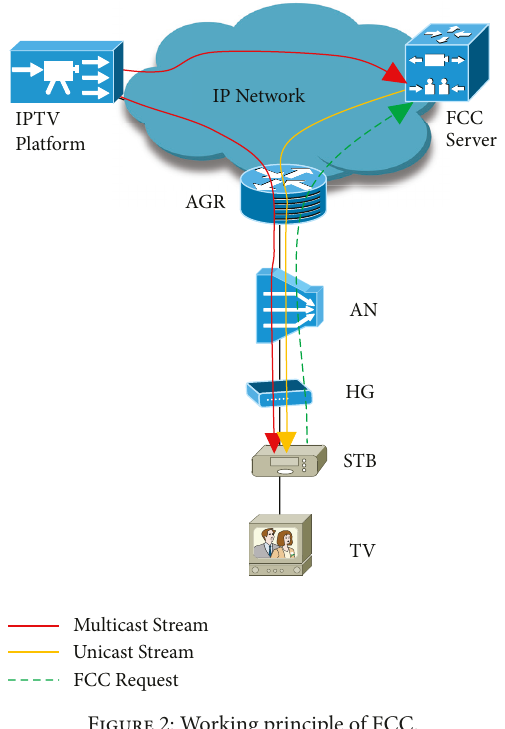
Figure 2: Working principle of FCC.